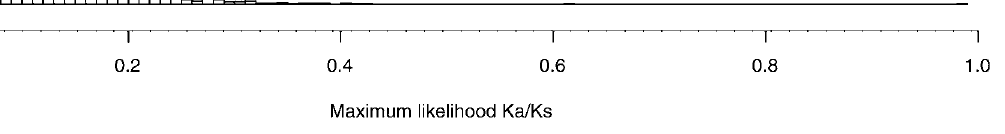
Figure 2. Distribution of K A /K S Ratio among Ortholog